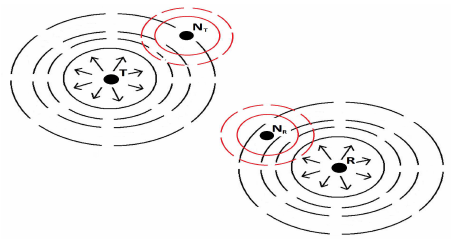
Figure 2. Interference caused by omnidirectional